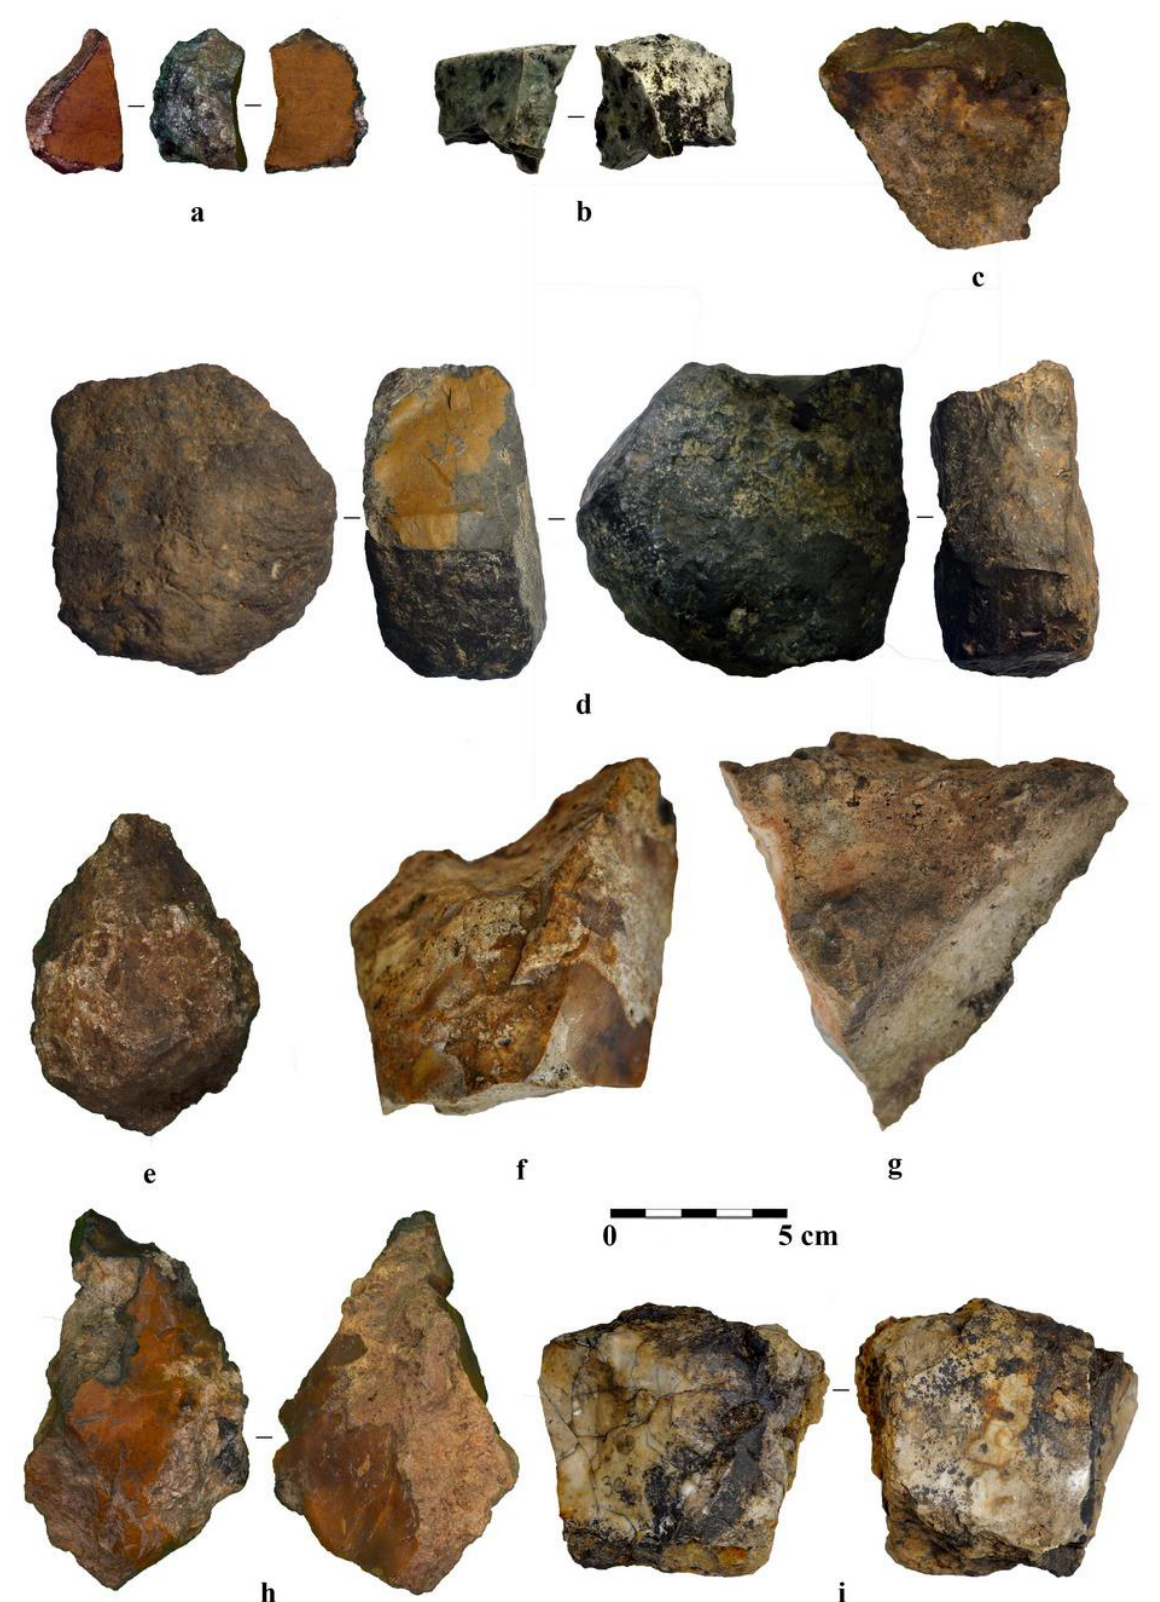
Figure 12. Lojanik 1, pieces of raw material, and artefacts: a) sample 5; b) sample 10; c) sample 17; d) sample 8; e) sample 11; f) sample 3; g) sample 20; h) sample 1; i) sample 14. See Table